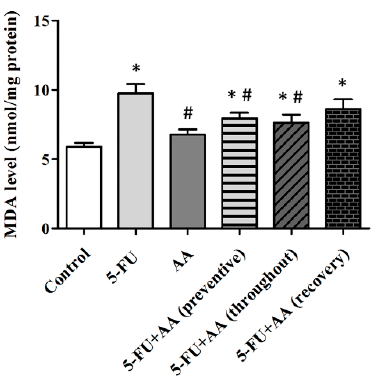
Figure 4. Malondialdehyde (MDA) levels (mean ± SEM) in the hippocampus. * p < 0.05 and # p < 0.05 compared with the controls and 5-FU groups, respectively. AA; asiatic acid, 5-FU; 5-fluorouracil. 3.4. Consequences of AA and 5 ‐ FU on Nrf2 Protein Expression in the Hippocampus